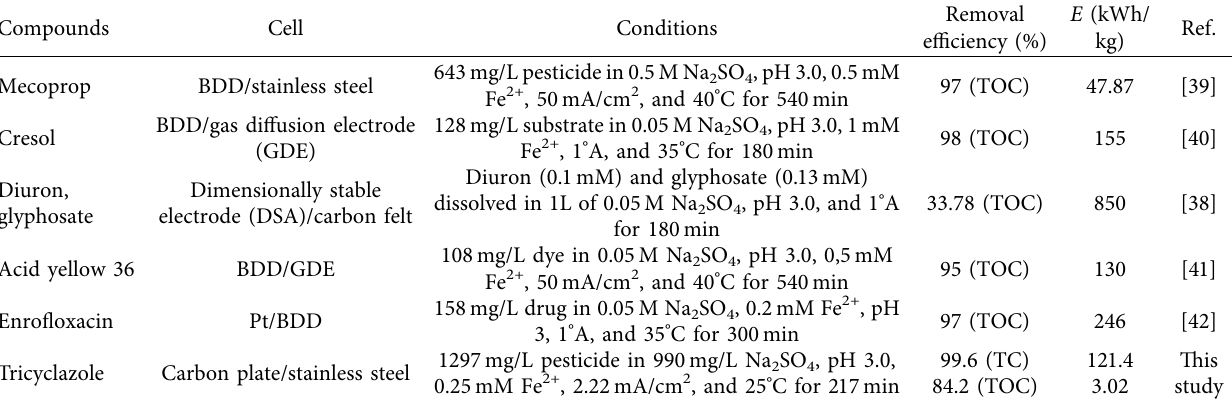
Table 5: Energy consumption per unit TOC mass for the degradation of several organic pollutant solutions by the EF process. Compounds